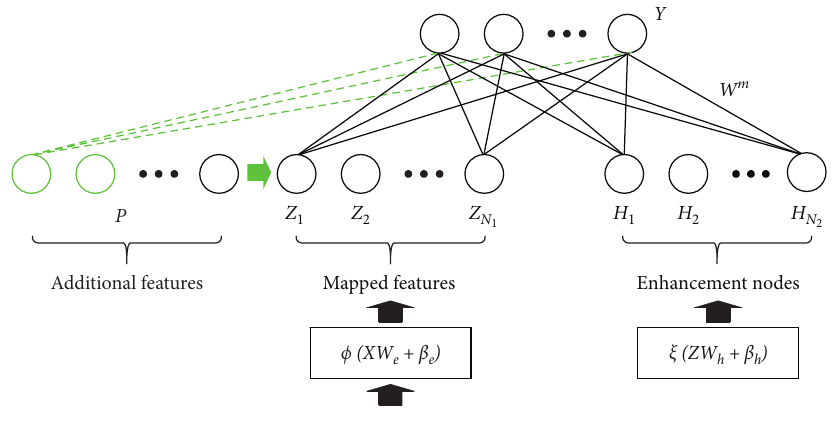
Figure 2: Network model of BLS.